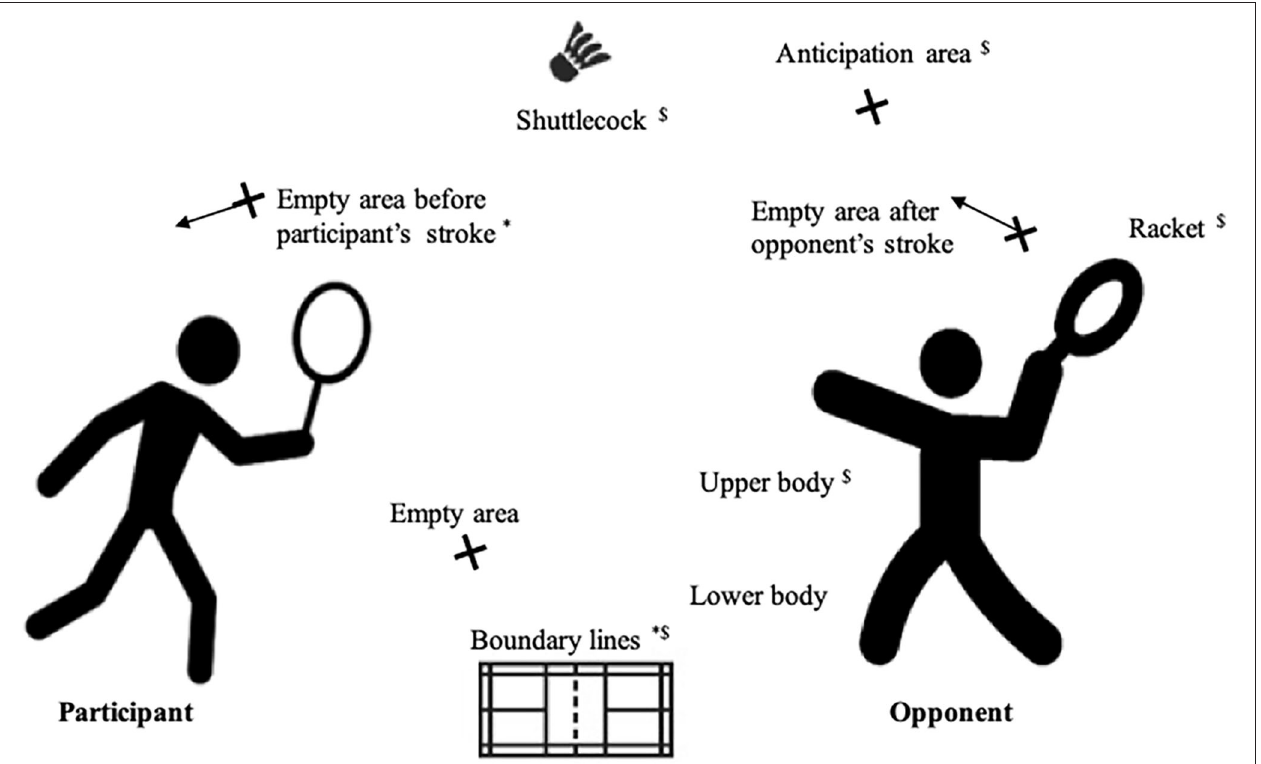
FIGURE 1 | Nine areas of interest analyzed for gaze behaviors. *Areas of interest involved in performance for win point. $ Areas of interest involved in performance for successful stroke.